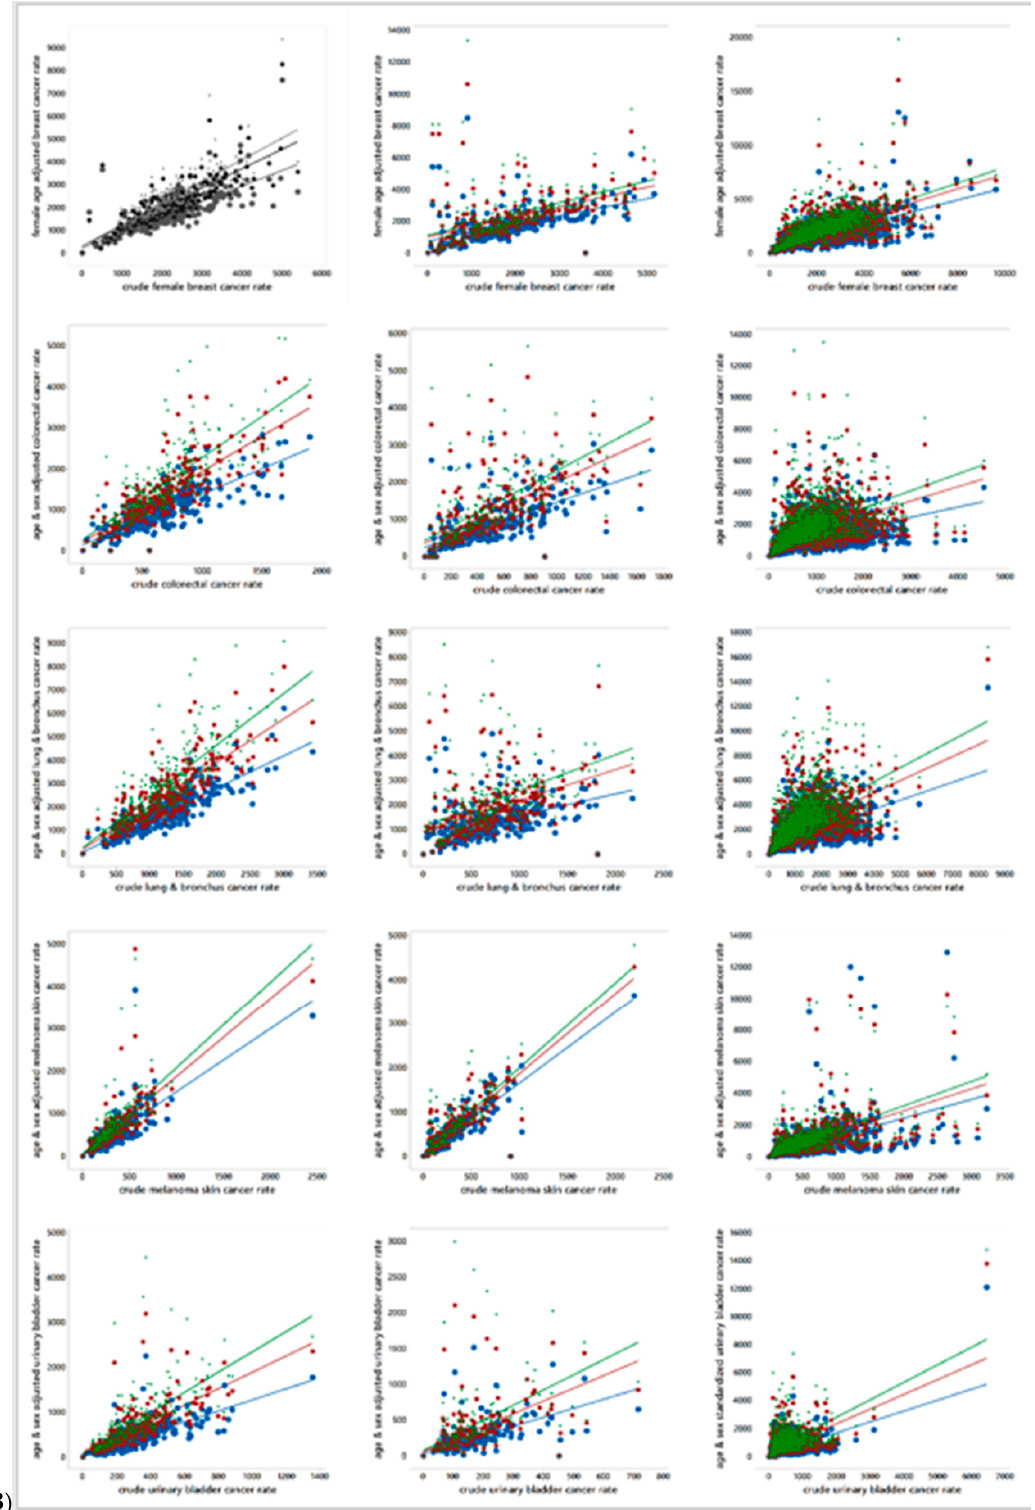
Figure 4. Scatterplots of crude cancer rates (vertical axis) versus age-and sex-adjusted cancer rates (horizontal axis); blue denotes World, red denotes US, and green denotes Florida (FL). ( A ). Top to bottom: cancer type (female breast, colorectal, lung & bronchus, melanoma skin, urinary bladder). Left to right: MSA (Jacksonville, Miami, Orland). ( B ). Top to bottom: cancer type (female breast, colorectal, lung & bronchus, melanoma skin, urinary bladder). Left to right: MSA Pensacola, Tallahassee, Tampa).